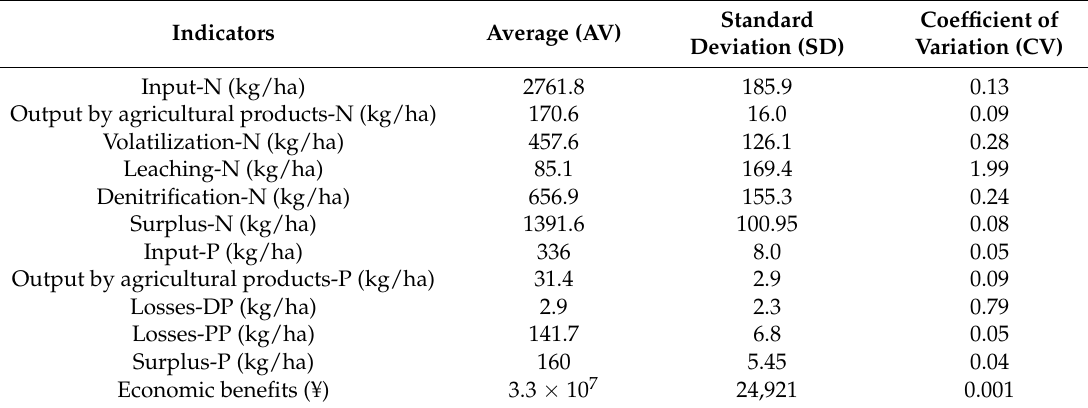
Table 3. Descriptive statistics analysis of nutrients balance in VLJF from 2000 to